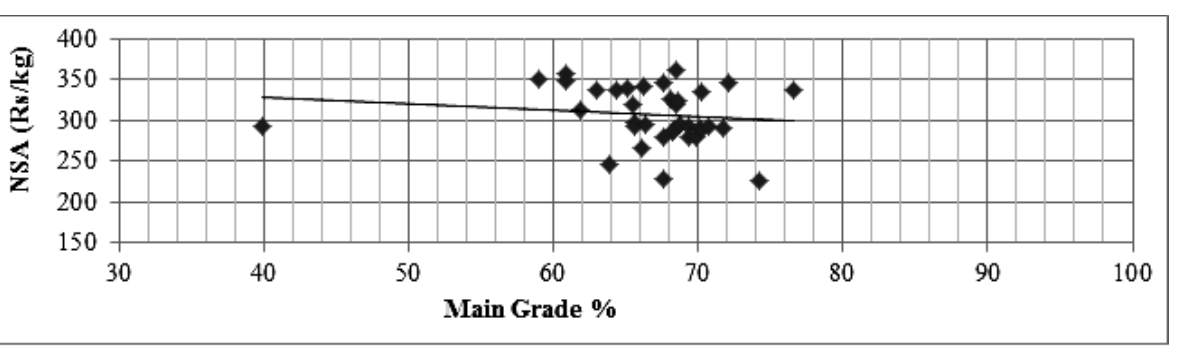
Fig 18: Relationship of Main Grade Percentage with NSA in Uva According to the fig.19 and 20, price variation in Uva is not substantial. Both graphs show different NSA values with same leaf quantities and vice versa. Therefore besides the own leaf quantity on making the price variations, there could be some other reasons which affects the